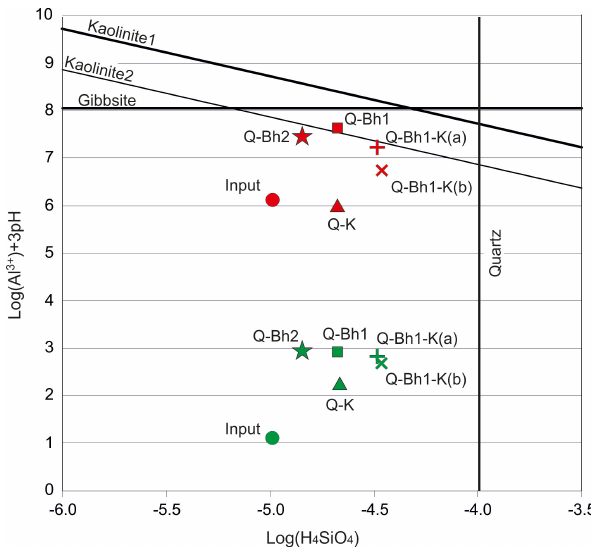
Figure 5. Situation of the studied solutions in the Si–Al system. Note: red symbols – without considering DOM–Al complexes; green symbols – considering DOM–Al